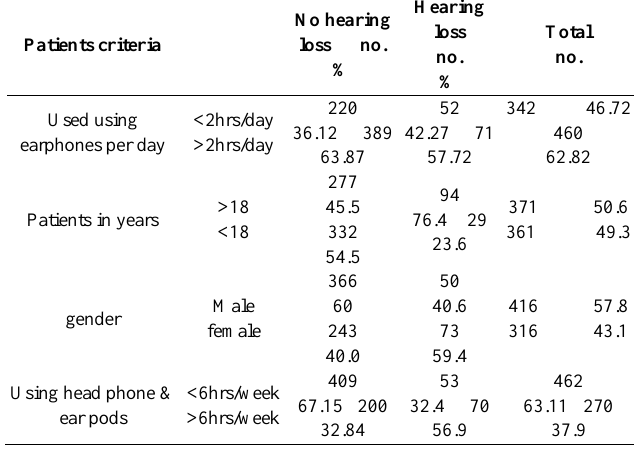
Table 3: percentages of patients in the study, according to the duration of their use of earphones and headphones (hour/day) and their effect on the level of hearing. and its relationship with age and gender Patients criteria